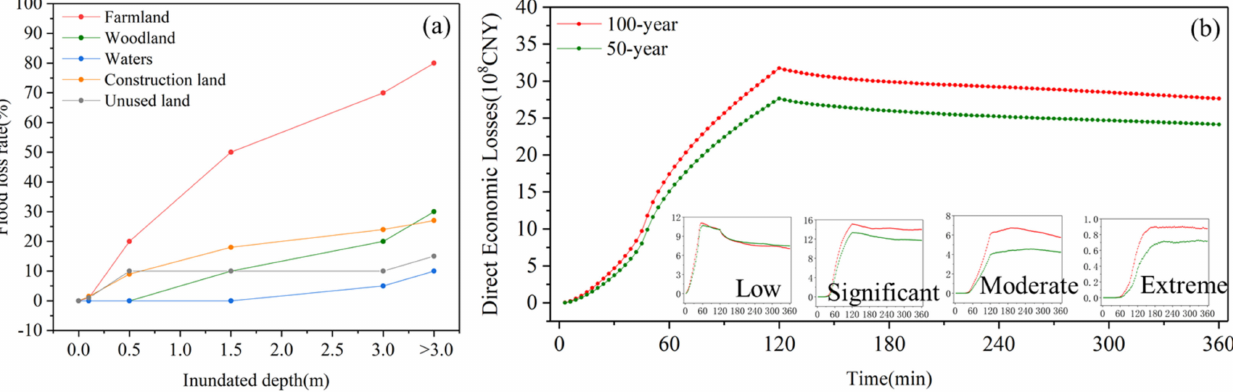
Figure 12. Flood loss ratio for different land use types and dynamic changes of direct economic loss under four flood hazard degrees for different return periods. ( a ) Flood loss rate; ( b ) direct economic